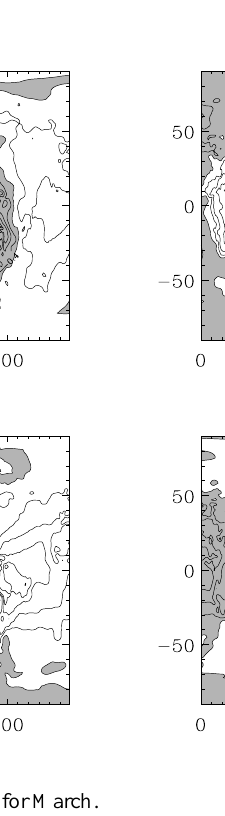
Fig. 1. Climatological daily cycle of surface pressure (mbar) calculated from 13 years of ECMWF analyses at 00:00, 06:00, 12:00, and 18:00UT. Negative values are shaded. Contour interval is 0.4mb.